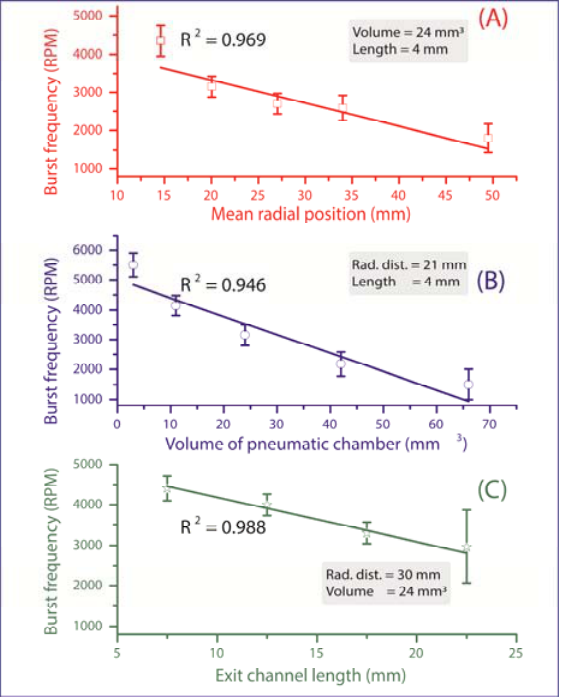
Figure 3. Graph demonstrating: Decrease in burst frequency as ( A ) The radial position of the DF valve on the disc platform increases, ( B ) As the volume of the compressed air increases Equation (2) and ( C ) As the exit channel length increases Equation (2). The error bars represent the standard deviation over three measurements on separate discs. The high R 2 values of the linear fit demonstrate the predictability of this parametric